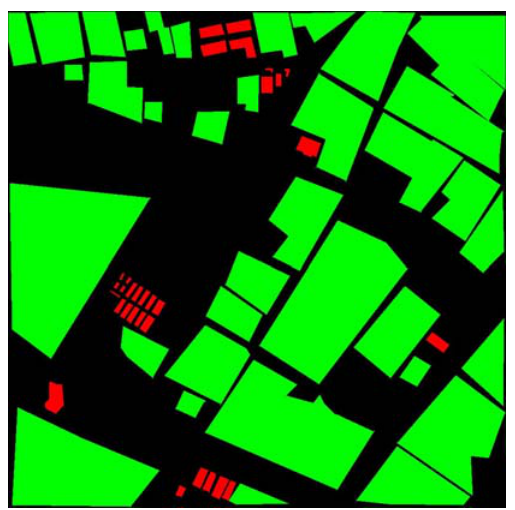
Figure 9. The pseudocolor VHR images acquired by GF ‐ 2 satellite on ( a ) 11 April 2016; and ( b ) 1